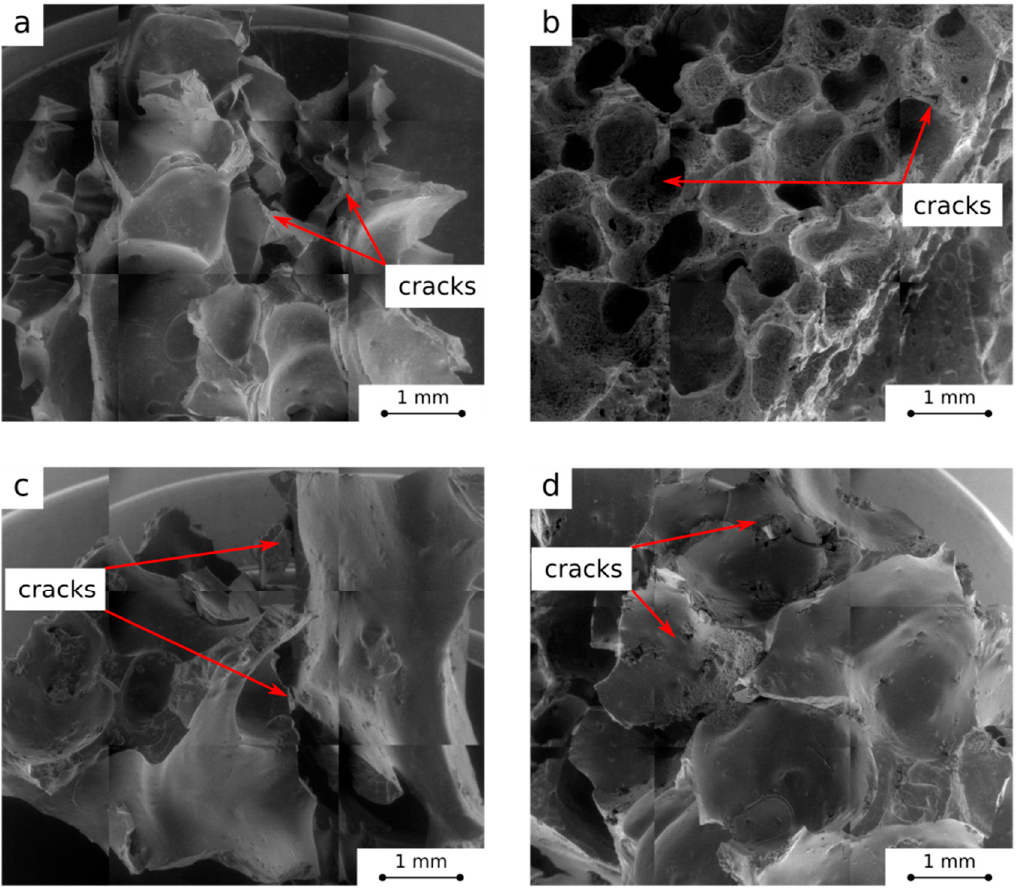
Figure 11. SEM micrographs after kerosene absorption of ( a ) SF-0, ( b ) CNT-0, ( c ) CNT-22, and ( d )